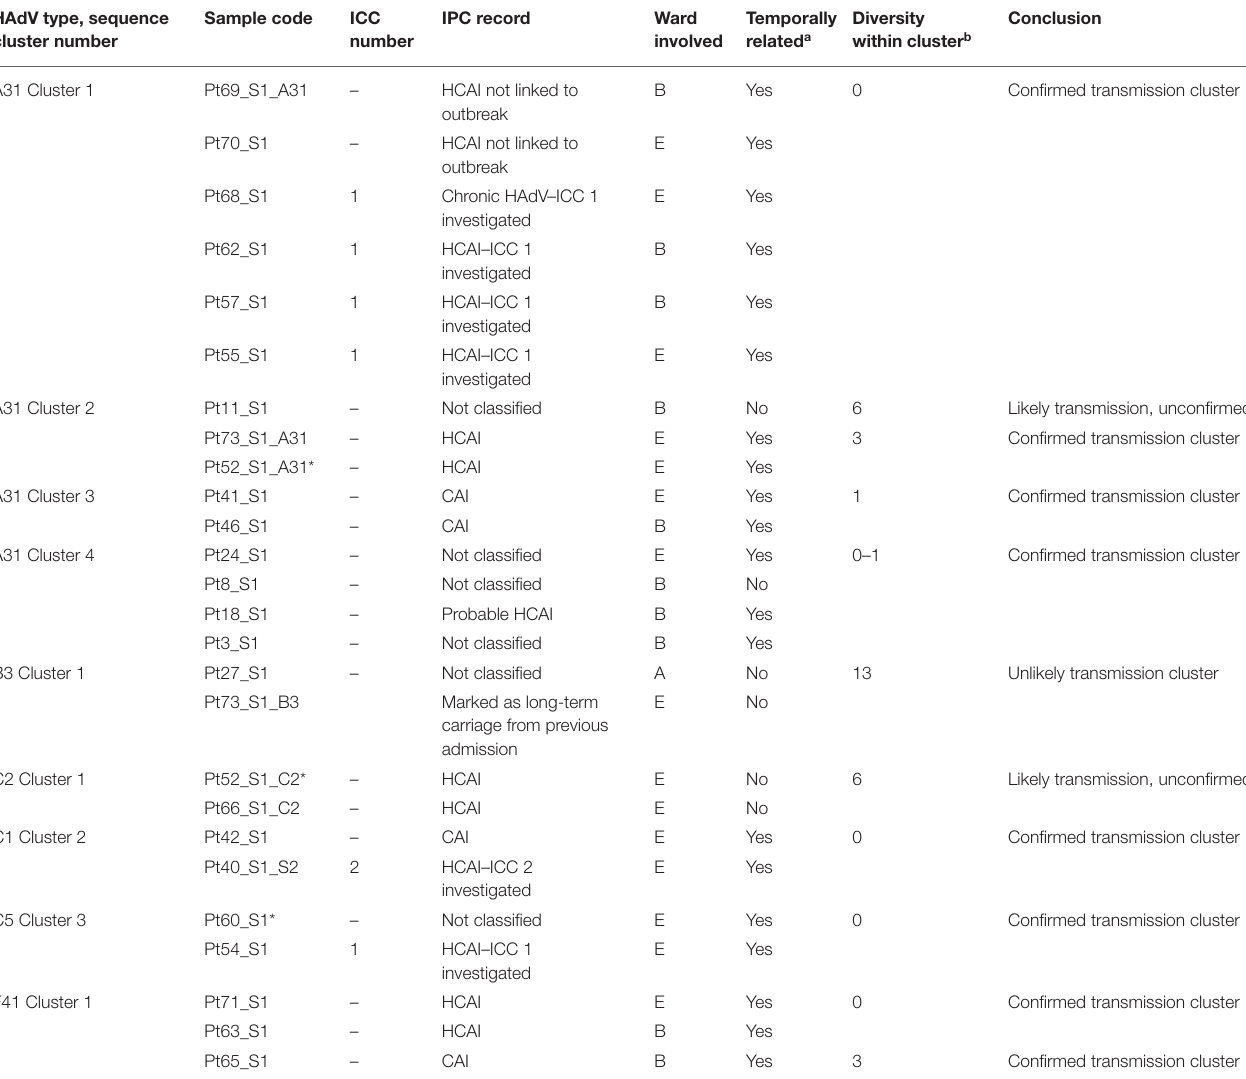
TABLE 1 | Summary of monophyletic clusters identified by maximum likelihood phylogeny using whole HAdV genome sequences. HAdV type, sequence cluster number